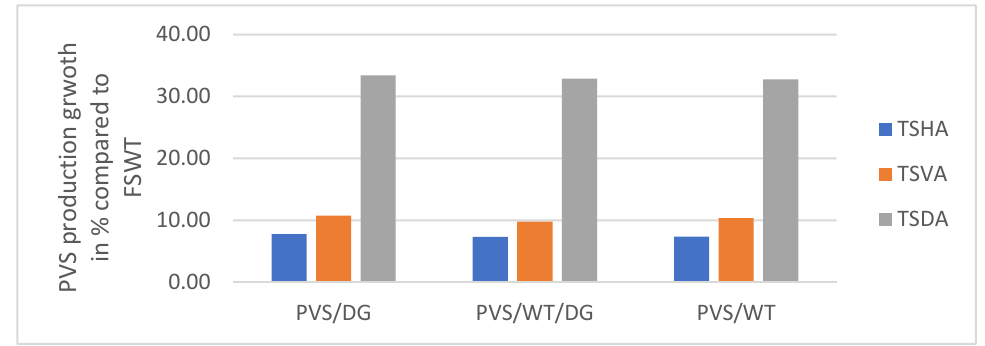
Figure 7. Comparison of different configurations for various tracking systems—PVS production growth in % when compared to FSWT.